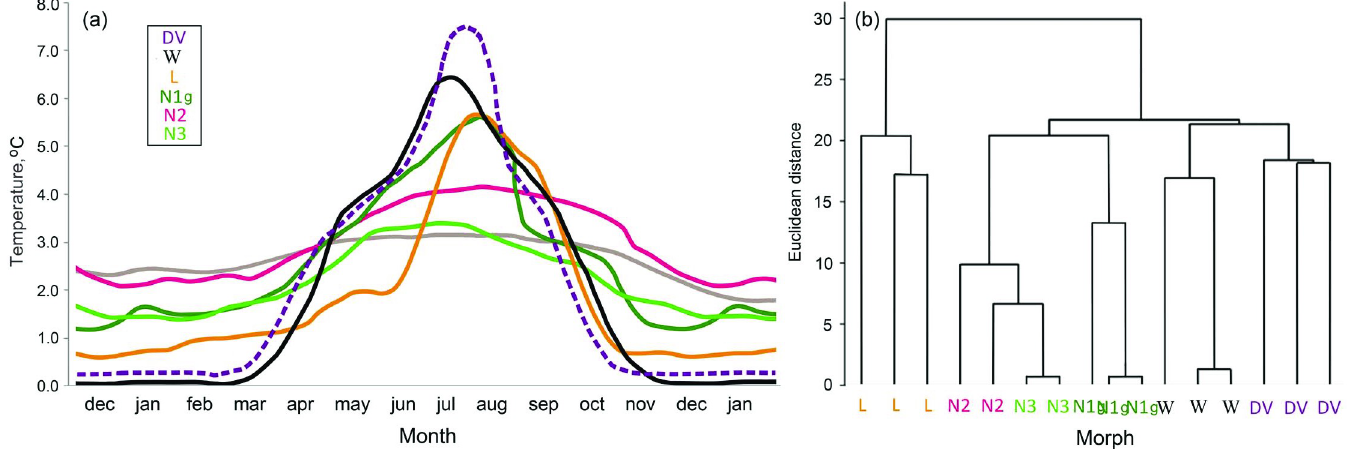
Fig 2. Annual dynamics of mean daily temperatures at the bottom water level at the spawning grounds of the Lake Kronotskoe charr morphs and Dolly Varden ( a ; coloured for different morphs, the standard temperature regime of rearing is shown in grey); clustering mean velocity of temperature change in winter, spring, summer and autumn to differentiate the spawning sited of the Lake Kronotskoe charr morphs and the anadromous Dolly Varden ( b ).